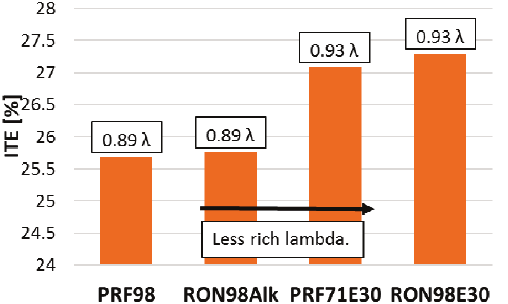
Fig. 5. Indicated thermal efficiency of each fuel at RON test conditions